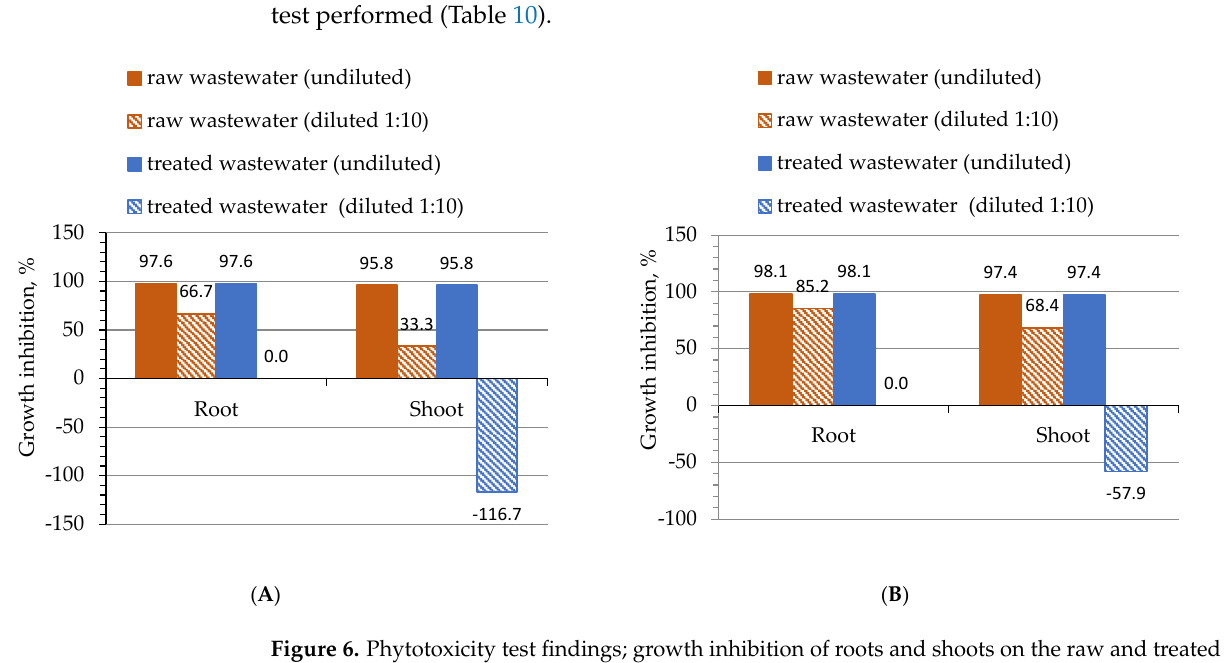
Figure 6. Phytotoxicity test findings; growth inhibition of roots and shoots on the raw and treated (in